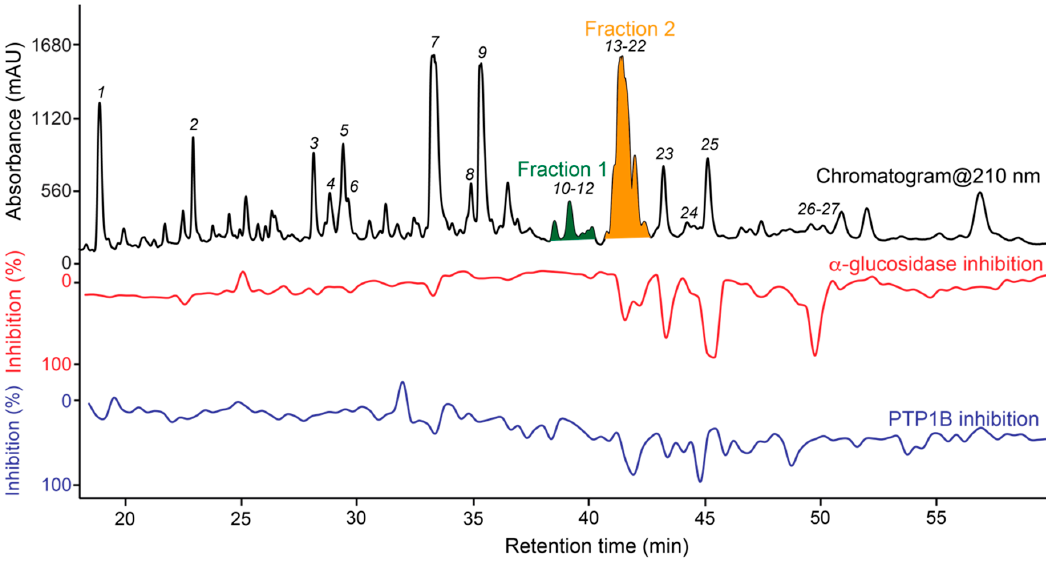
Figure 1. Dual high-resolution PTP1B/ α -glucosidase inhibition profile of the crude ethyl acetate extract of Gerbera piloselloides shown with the UV chromatogram at 210 nm.